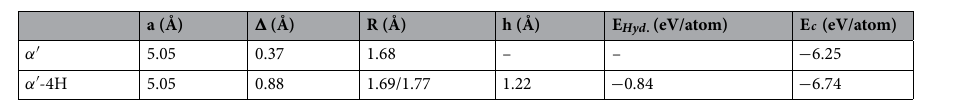
Table 1. Structural parameters of the pure and hydrogenated borophene at the GGA level: lattice constant (a), buckling height ( (cid:31) ), bond length (R), adsorption length (h), hydrogenation energy ( E Hyd . ), and cohesive energy ( E c